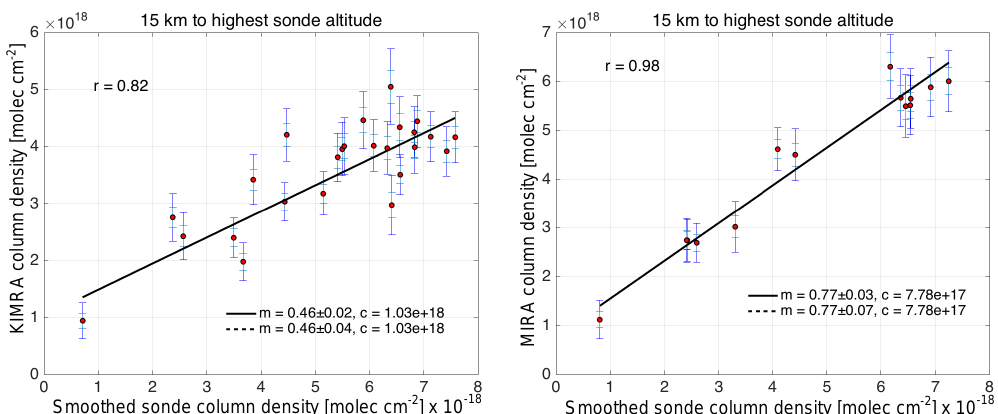
Figure 5. Left: scatter plot of the KIMRA O 3 partial columns against Sodankylä ozonesonde partial columns from November 2012 through to May 2013. The line of best fit is shown with the accompanying correlation coefficient. The slope ( m ) and its standard error, and the intercept ( c ) for each line are shown. Error bars and lines of fit are shown for two cases of error estimation for KIMRA, as in Fig. 4. Right: the same as left plot but for MIRA 2 and Sodankylä ozonesonde measurements from December 2012 through to April 2013.